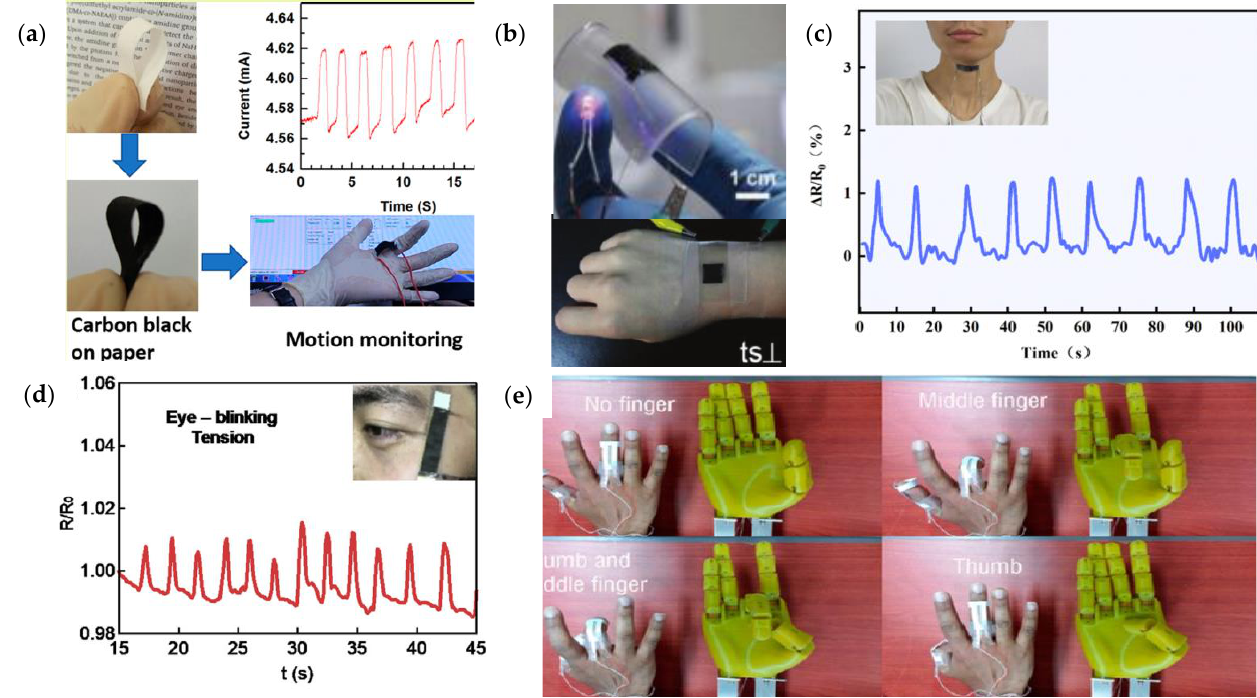
Figure 10. Representative of flexible strain sensors with biological substrate. ( a ) Flexible and degradable paper-based strain sensor (Reprinted with permission from ref. [110]. Copyright 2017 American Chemical Society; ( b ) Flexible and anisotropic strain sensor based on carbonized crepe paper for monitoring human wrist bending (Reprinted with permission from ref. (Reprinted with permission from ref. [112]. Copyright 2018 WILEY ‐ VCH Verlag GmbH & Co. KGaA, Weinheim); ( c ) Strain sensor was applied to monitor drinking water (Reprinted with permission from ref. [113]. Copyright 2019 American Chemical Society); ( d ) Paper sensors for detecting eye blinking motions (Reprinted with permission from ref. [114]. Copyright 2019 Elsevier; ( e ) Foldable paper sensors based on reduced graphene oxide for control of a robotic hand (Reprinted with permission from ref. [111]. Copyright 2017 American Chemical Society).